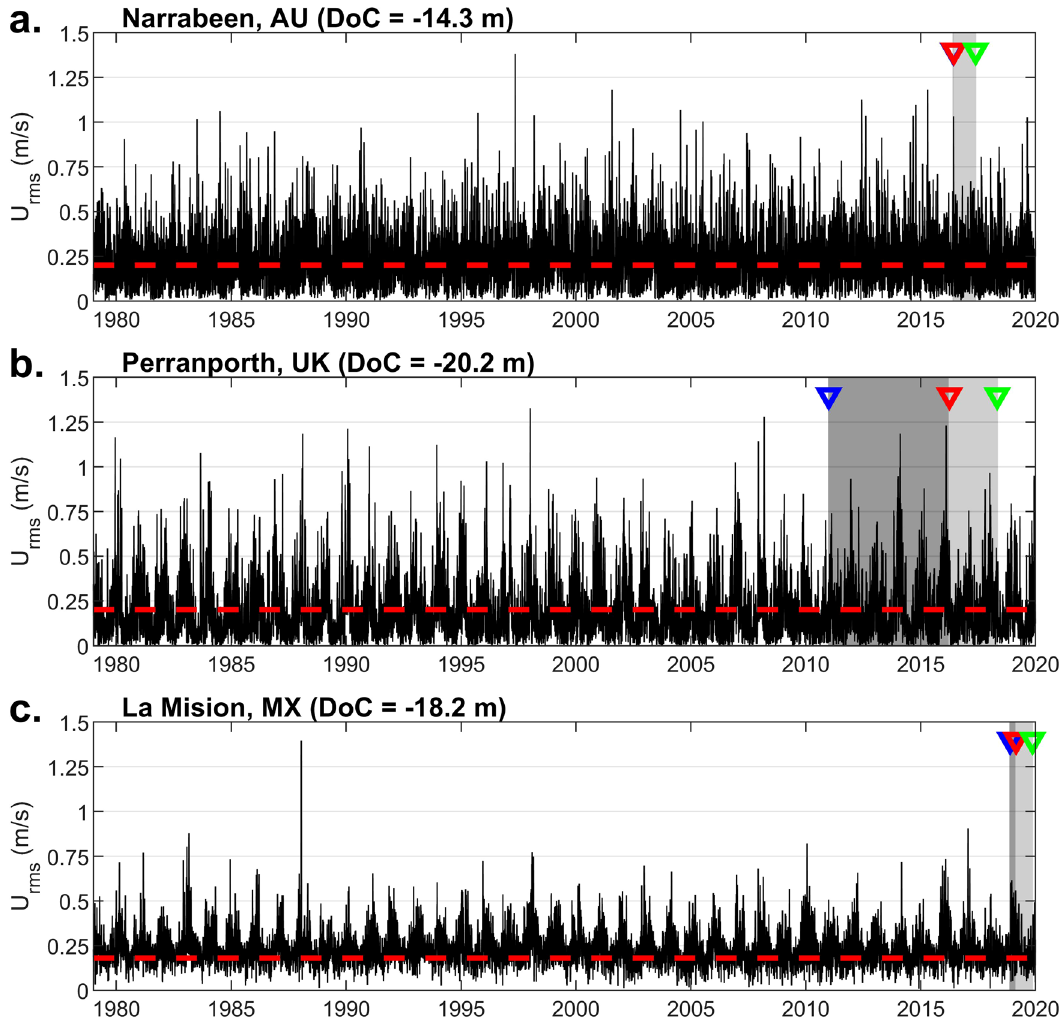
Fig. 7 Estimates of historical sediment transport potential at the depth of closure. Wave orbital velocities ( U rms ) at the depth of closure (DoC) are derived from ERA5 wave reanalysis (1979 – 2020) at each of the three study sites: a Narrabeen, Australia; b Perranporth, UK; and c La Misión, Mexico. Shaded regions denote the storm-recovery sequences at the three sites, with darker regions corresponding to the storm periods and lighter regions the recovery periods. Colored triangles indicate the timing of pre-storm (blue), post-storm (red) and recovery (green) surveys. As an indication of potential sediment transport, the approximate critical threshold of motion for typical shoreface sediment ( U ≈ 0.2 m/s) is indicated as a red dashed line.